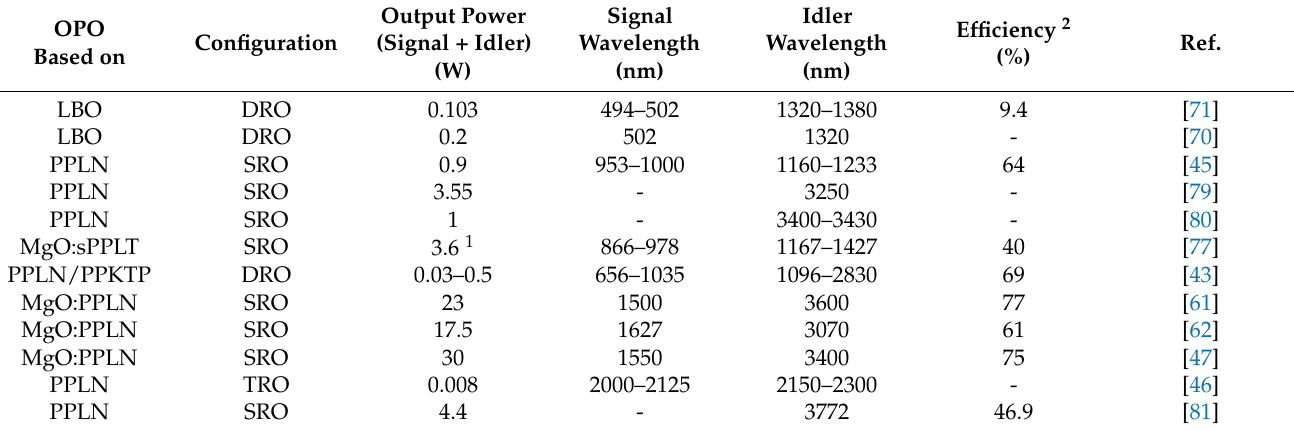
Table 2. Examples of CW OPOs with cavity configuration, output power, spectral ranges, and efficiency. OPO Based